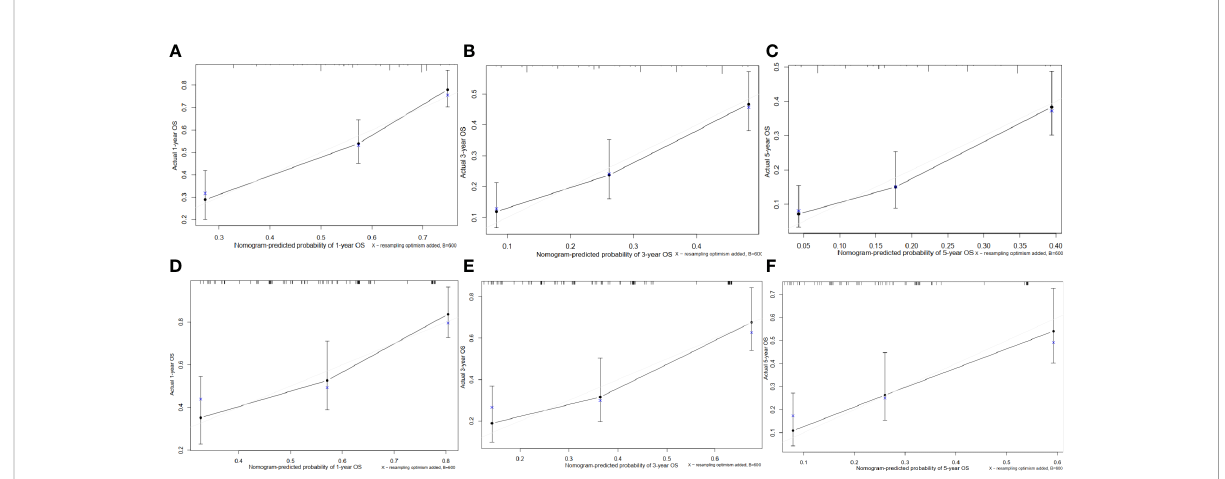
FIGURE 4 Calibration curves of the prognostic nomogram for each cohort. (A) Calibration curve of the nomogram for the training cohort at 1 year. (B) Calibration curve of the nomogram for the training cohort at 3 years. (C) Calibration curve of the nomogram for the training cohort at 5 years. (D) Calibration curve of the nomogram for the validation cohort at 1 year. (E) Calibration curve of the nomogram for the validation cohort at 3 years. (F) Calibration curve of the nomogram for the validation cohort at 5 years.